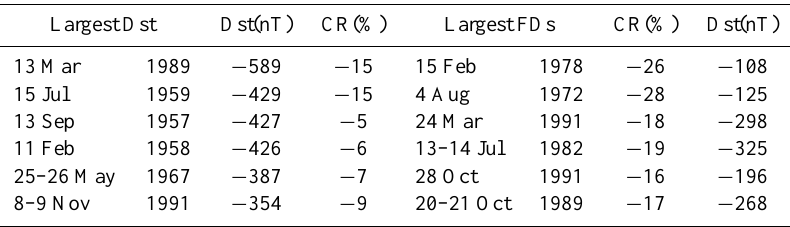
and 30 October 2003. Table 3. Details of the six largest Dst events and six largest FDs in cycles